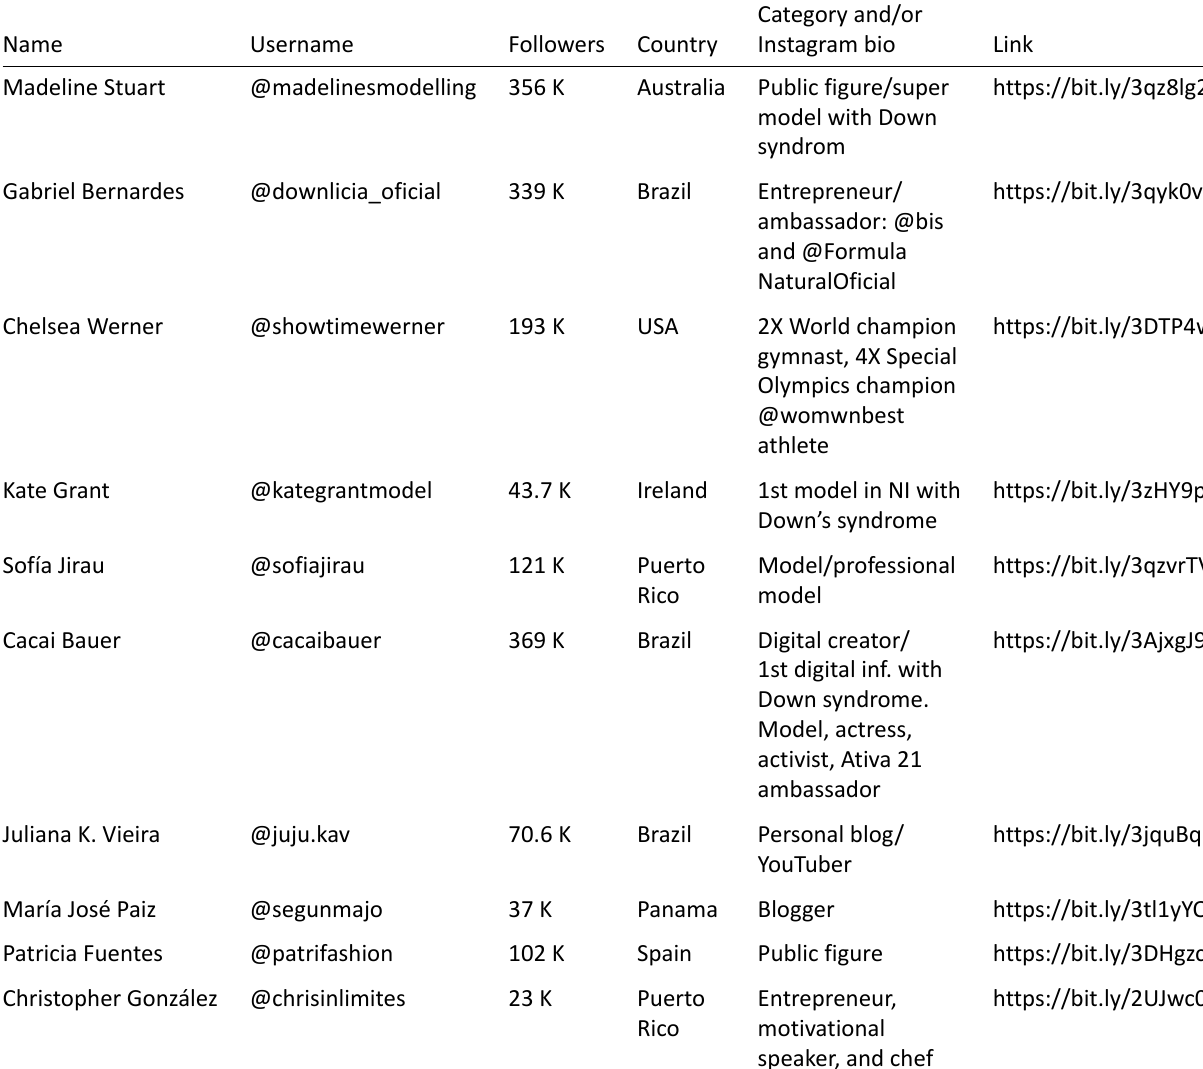
Table 1. Sample characteristics.